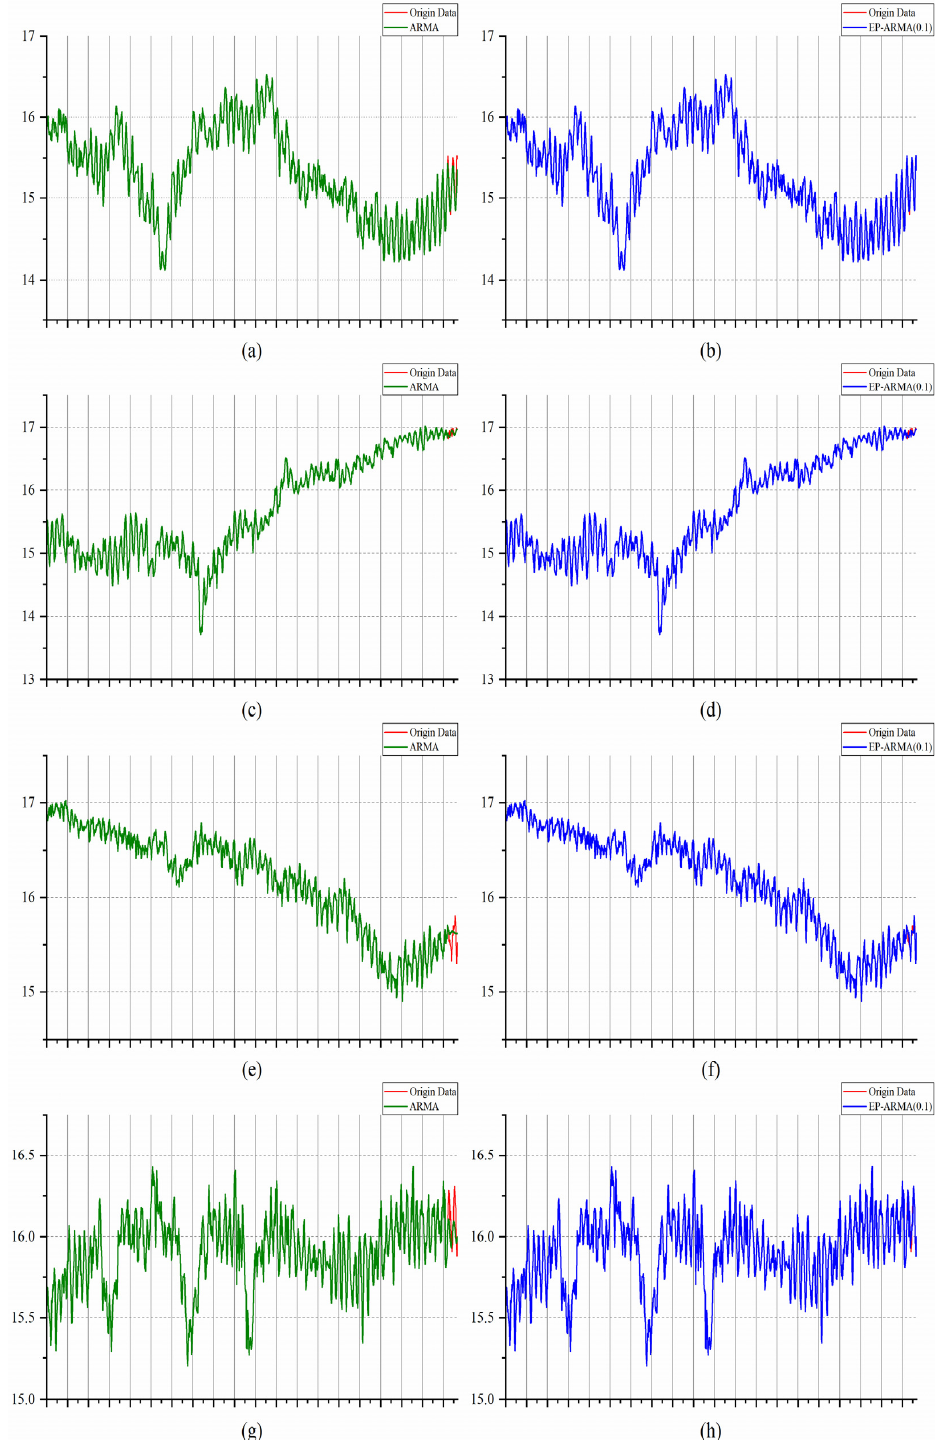
Figure 9. Comparison of ARMA and EP-ARMA algorithm prediction data and original monitoring data in different periods. Figures ( a , c , e , g ) in the left part reflect the comparison between the original monitoring data and ARMA prediction data in the periods (0, 960), (960, 1920), (1920, 2880), and (2880, 3840), and in the next 24 h period. Figures ( b , d , f , h ) in the right part reflect the comparison between the original monitoring data and EP-ARMA (0.1) correction data in the periods (0, 960), (960, 1920), (1920, 2880), and (2880, 3840), and in the next 24 h period.